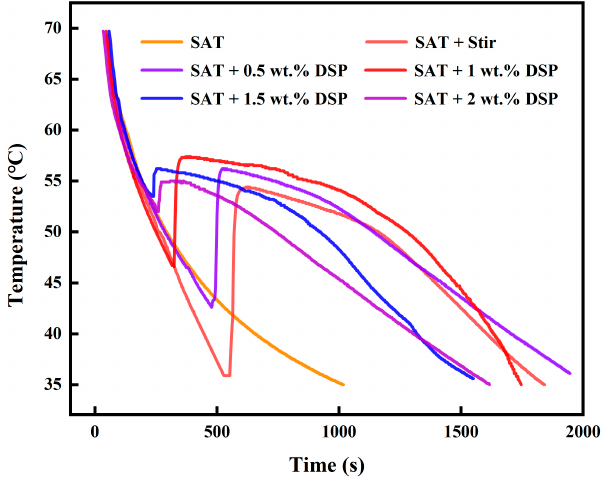
Figure 2. Supercooling curve using stirring or DSP.